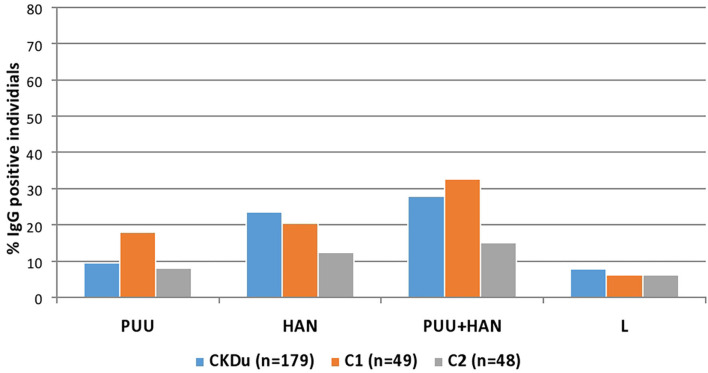
Hantavirus and Leptospira specific IgG in CKDu patients and healthy control groups; C1 and C2. CKDu: Chronic Kidney disease patients in high-CKDu prevalent area, C1: healthy blood relatives in high-CKDu prevalent area, C2: healthy individuals from low-CKDu prevalent area. PUU: Puumala strain specificity, HAN: Hantaan strain specificity, PUU+HAN: Total number positive for either Hantaan, Puumala and both strains, L: Leptospira specificity.